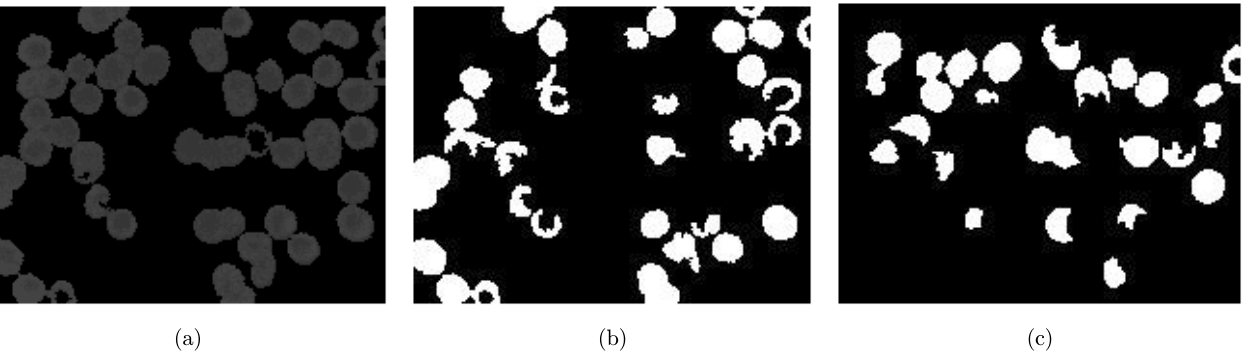
Fig. 6. Complex overlappingerythrocyte clusterscounting. (a)Cluster with K-means,(b) upperstrataonesand(c)lower